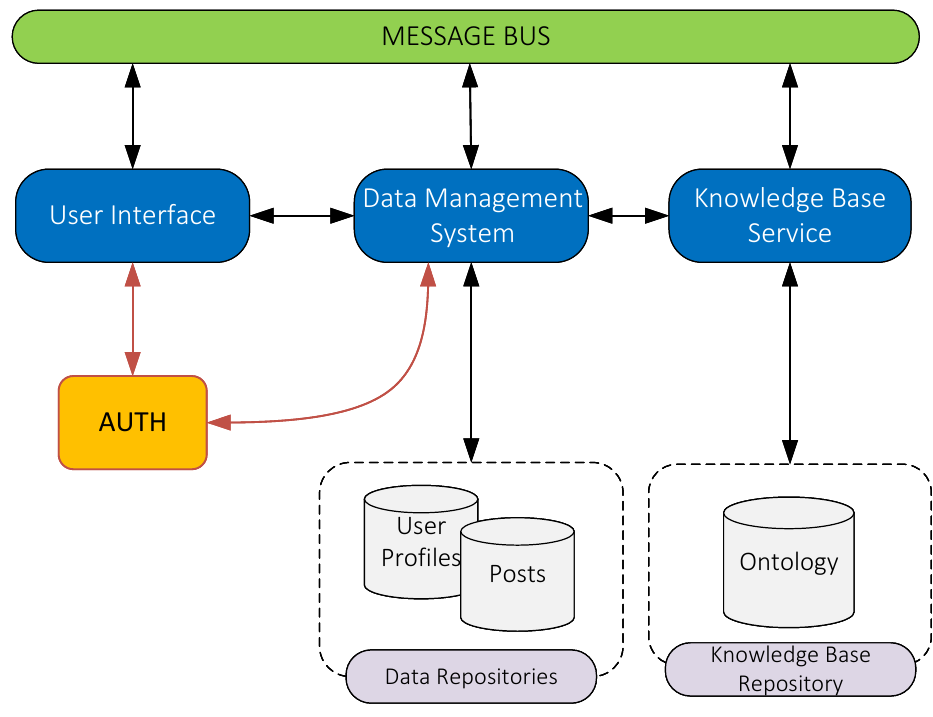
Figure 1. The IMMERSE